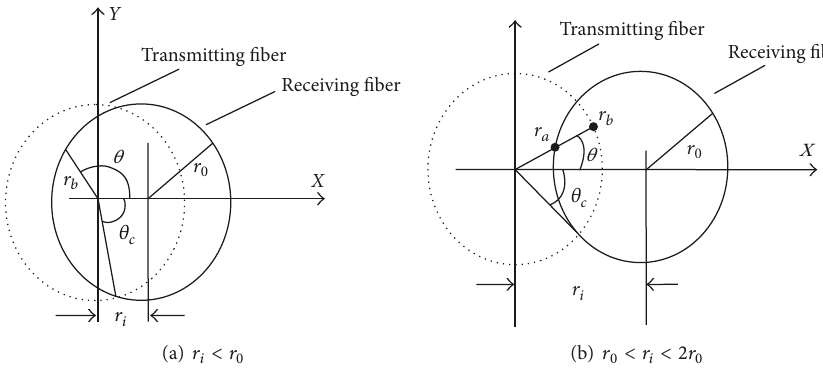
Figure 1: The coordinates of the transmitting and receiving